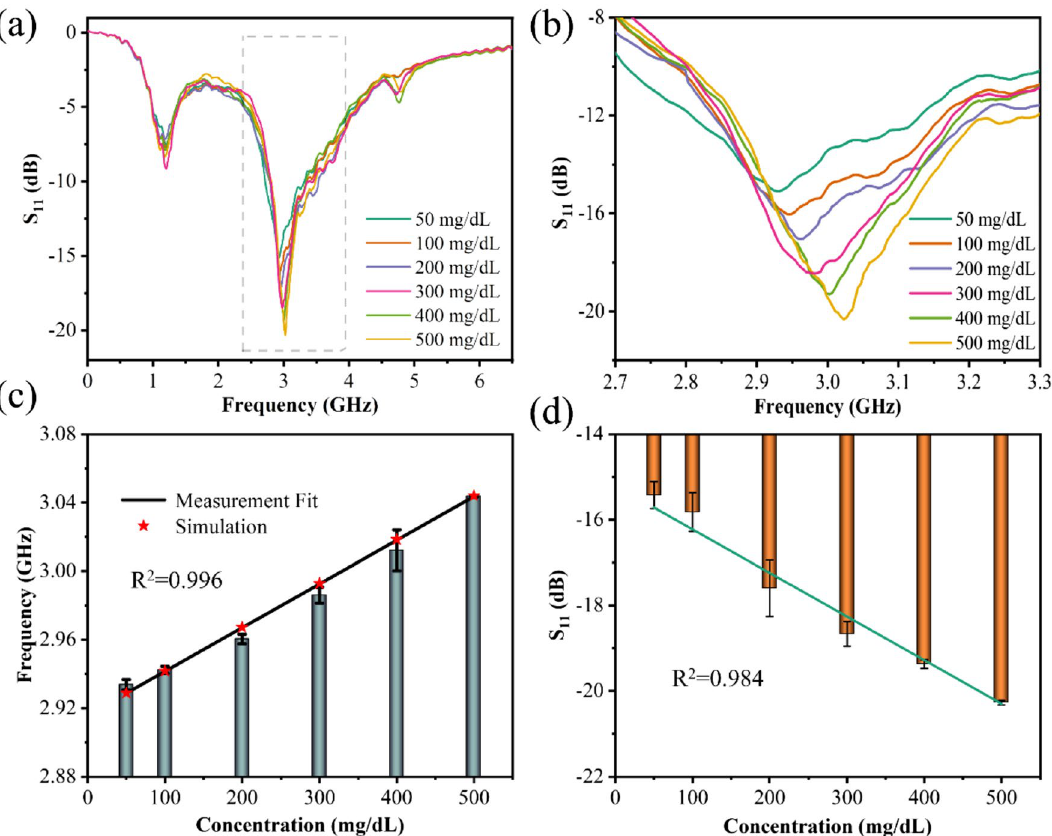
( c ) the linear fitting diagram of the resonance frequency with the concentration of glucose solution, ( d ) the linear fitting diagram of S 11 with the variation of the concentration of glucose solution.